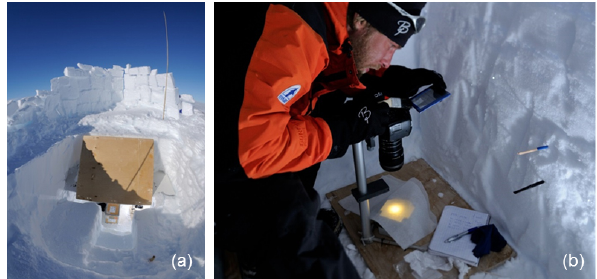
Figure 4. The cave dug in the snowpack (a) created a cold envi- ronment, sheltered from wind and radiation, which was suitable for snow macrophotography (b) . Photos by Timo